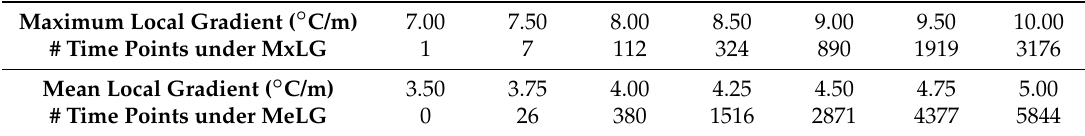
Table 3. Number of time points identified by different methods using Local Gradient (LG) metric. Maximum Local Gradient (°C/m)